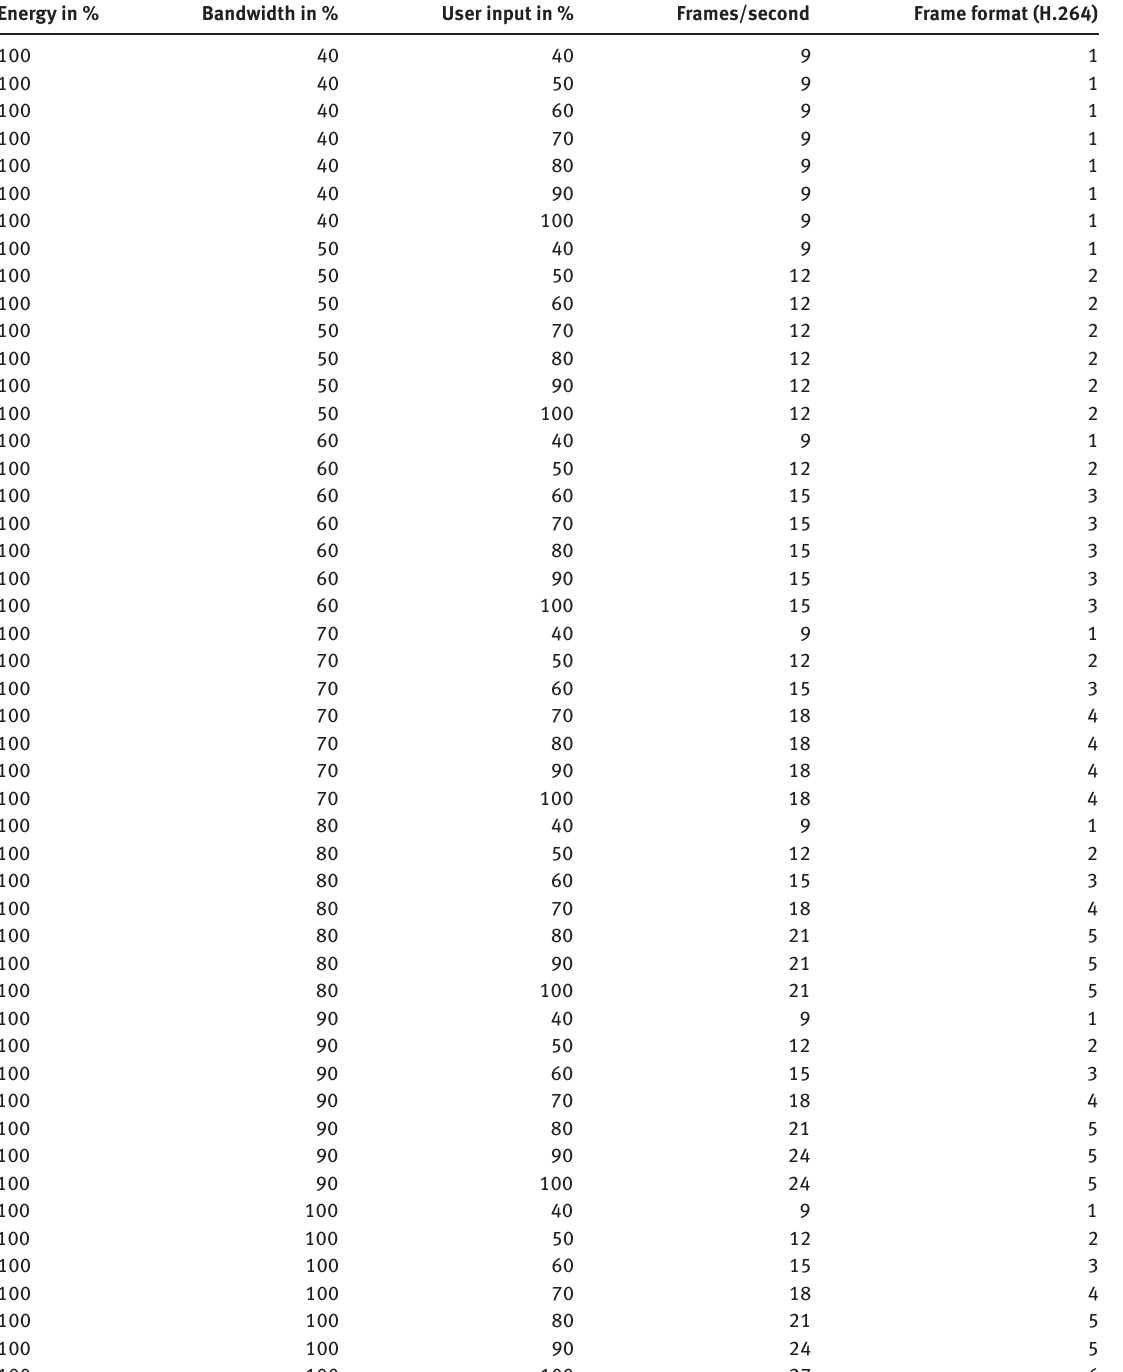
Table 2: ANFIS Training